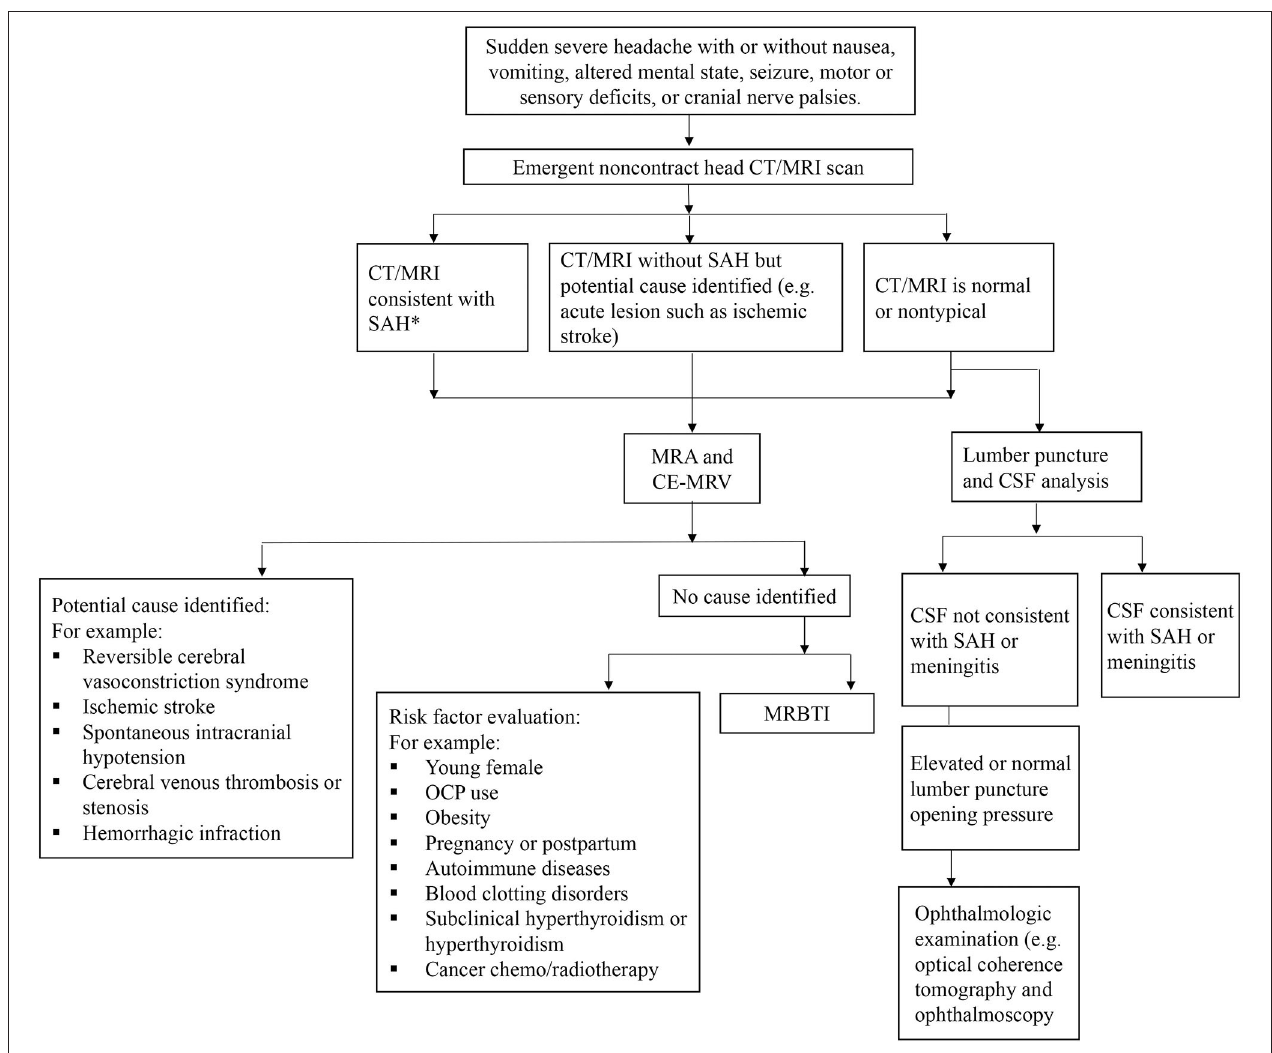
FIGURE 6 | Algorithm of management for